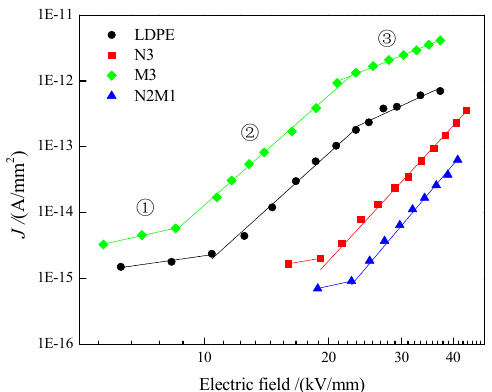
Figure 9. Electrical conductance current of neat LDPE and ZnO / LDPE composites versus an applied electric field.